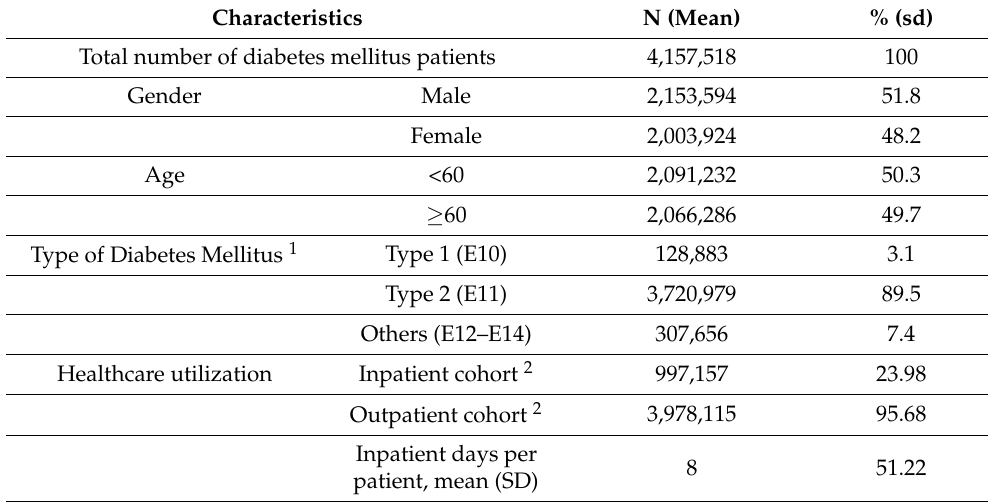
Table 2. Characteristics of patient cohort.